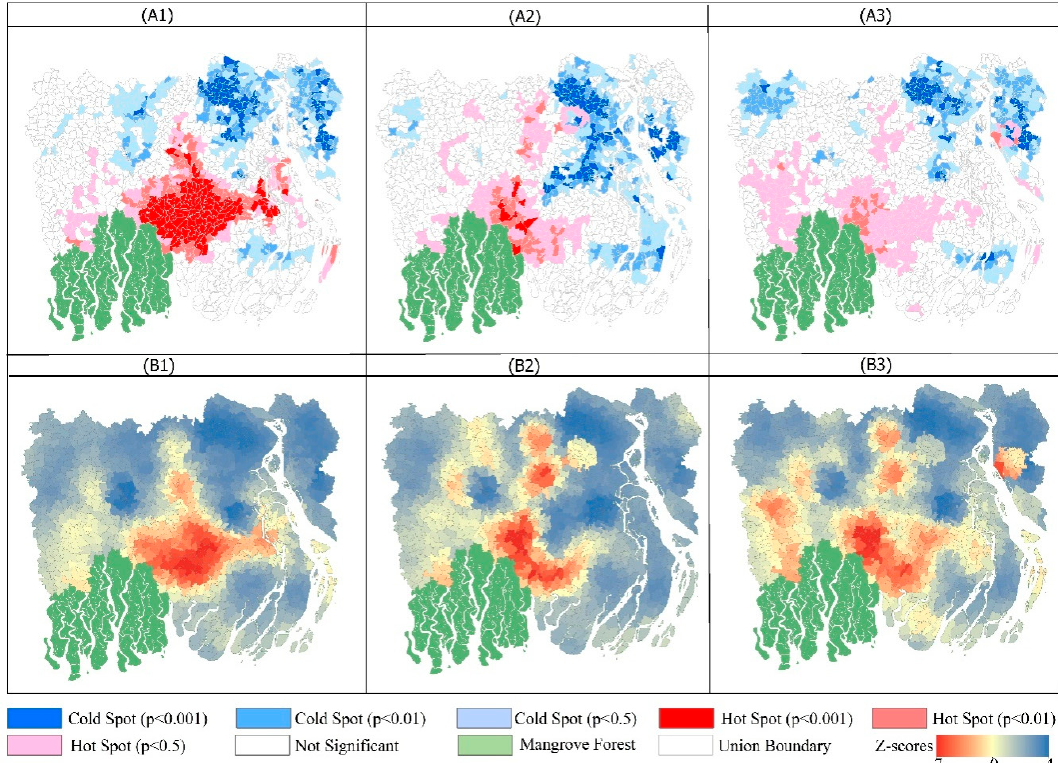
Figure 6. Hotspot and unaffected regions of cyclone Amphan triggered flooding on ( A1 ) 22 May, ( A2 ) 28 May, and ( A3 ) 7 June. The red colors in maps ( B1 ), ( B2 ), and ( B3 ) correspond to the locations of high Getis–Ord Gi* z-scores corresponding to the maps in ( A1 ), ( A2 ), and ( A3 ) signifying the location of flooding inundation hotspots.